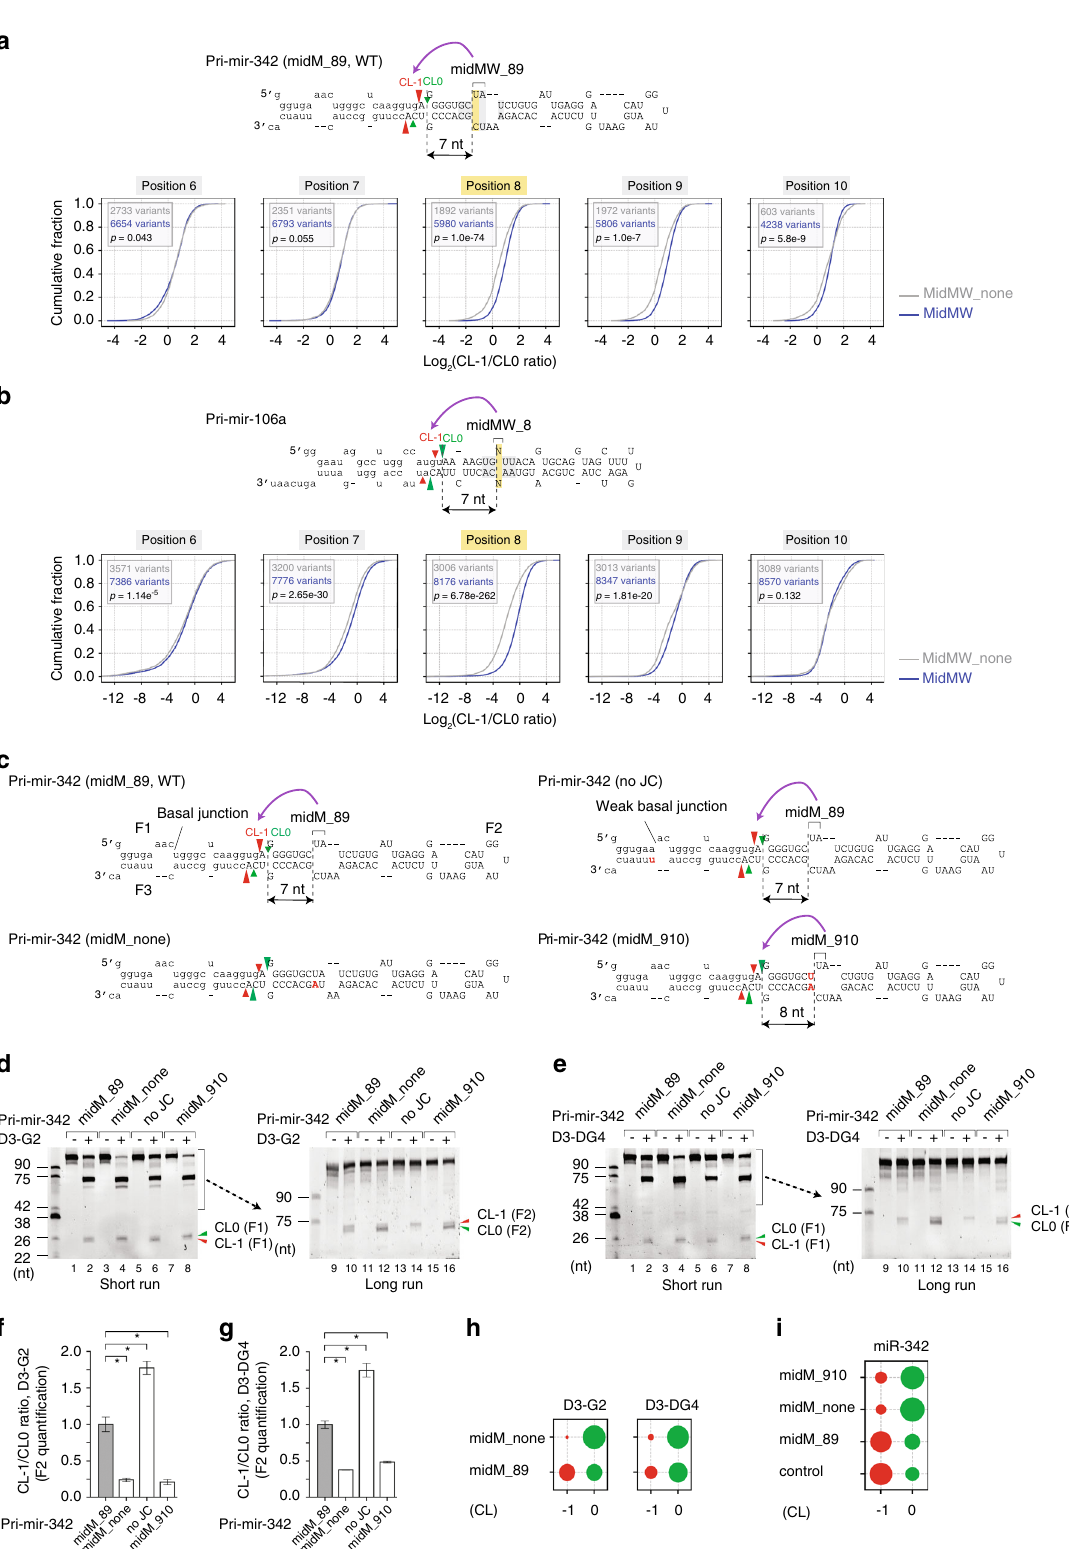
at different positions on the ef fi ciency of the productive cleavage activity of DROSHA (i.e., at CL0). Thus, we estimated the cleavage score of DROSHA at CL0 for each variant of arti1. The CL0 cleavage score was calculated as a ratio of the CL0 product to the original substrate. First, we compared the averaged CL0 cleavage score of the variants containing a mismatch within NATURE COMMUNICATIONS| (2020) 11:1926